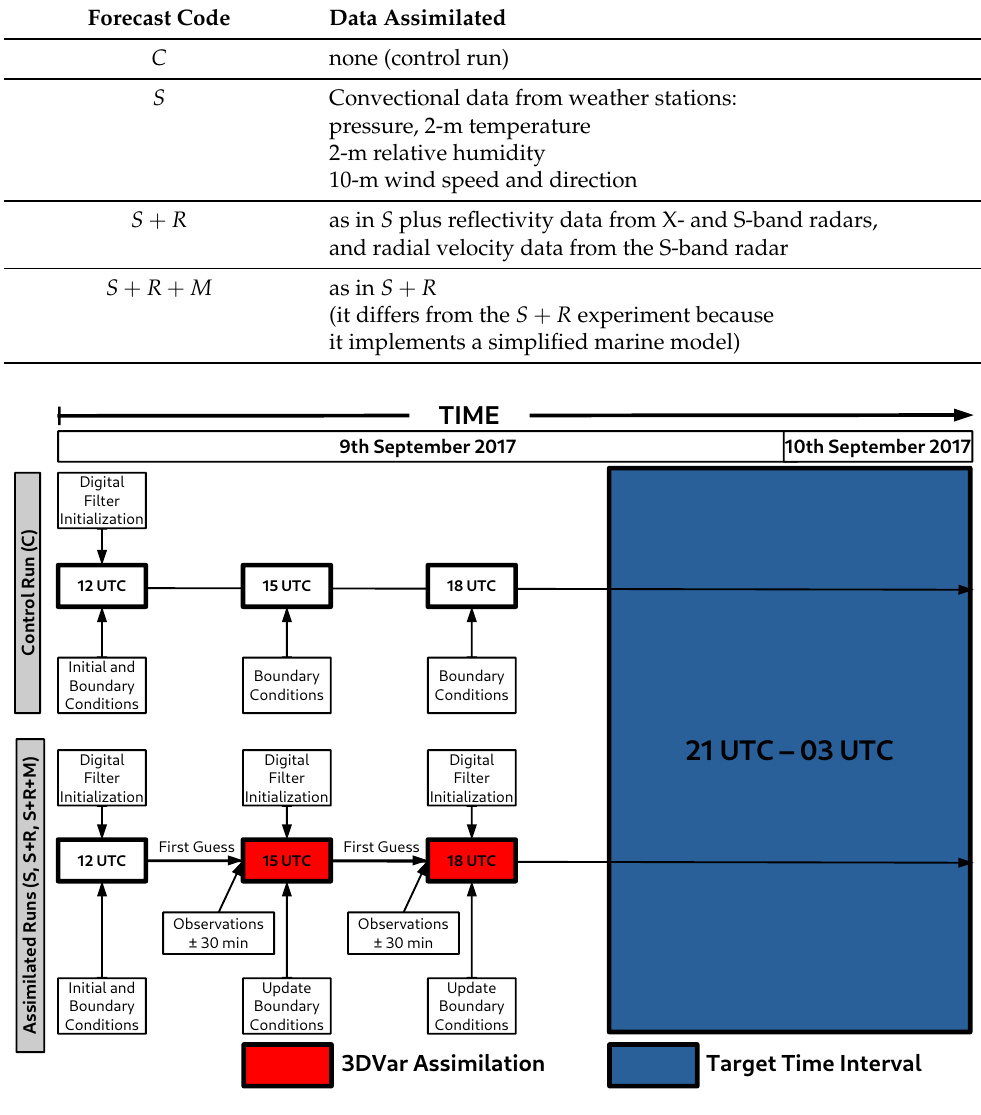
Figure 6. Modeling setup of the WRF control run C and assimilated runs S , S + R , and S + R + M